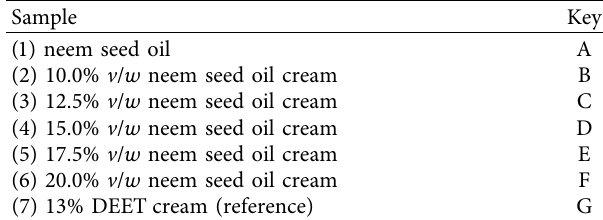
Table 1: List of samples for the repellency test. Sample